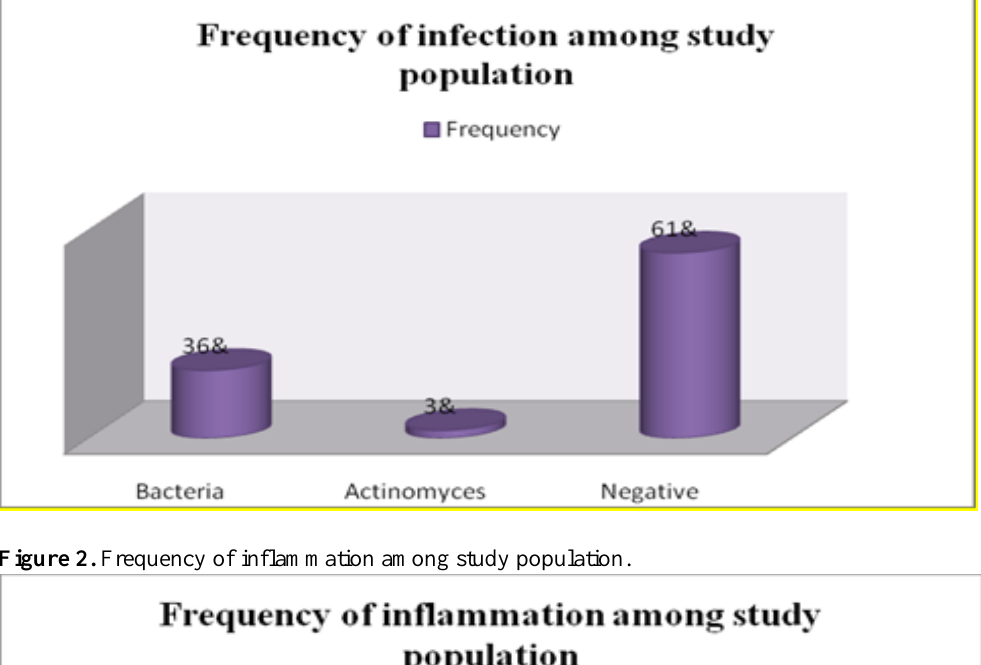
Figure 1. Frequency of infection among study population.